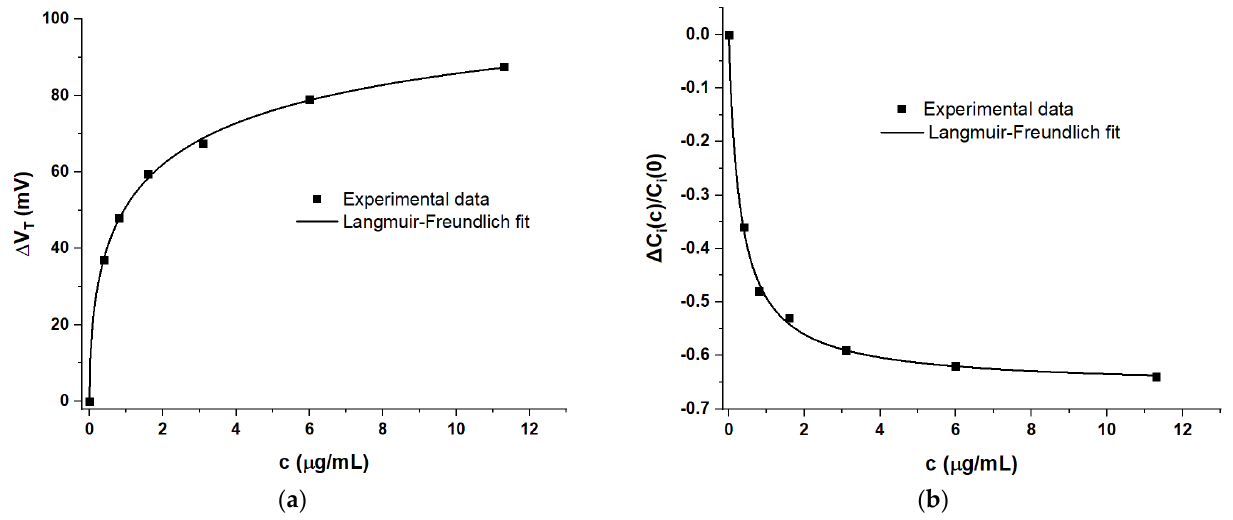
Figure 6. ( a ) Potentiometric response metric Δ V T (c) and ( b ) capacitive response metric Δ V T (c) and Δ C i (c)/C i (0) plotted against RBD spike protein concentration, c, in the sample pool.